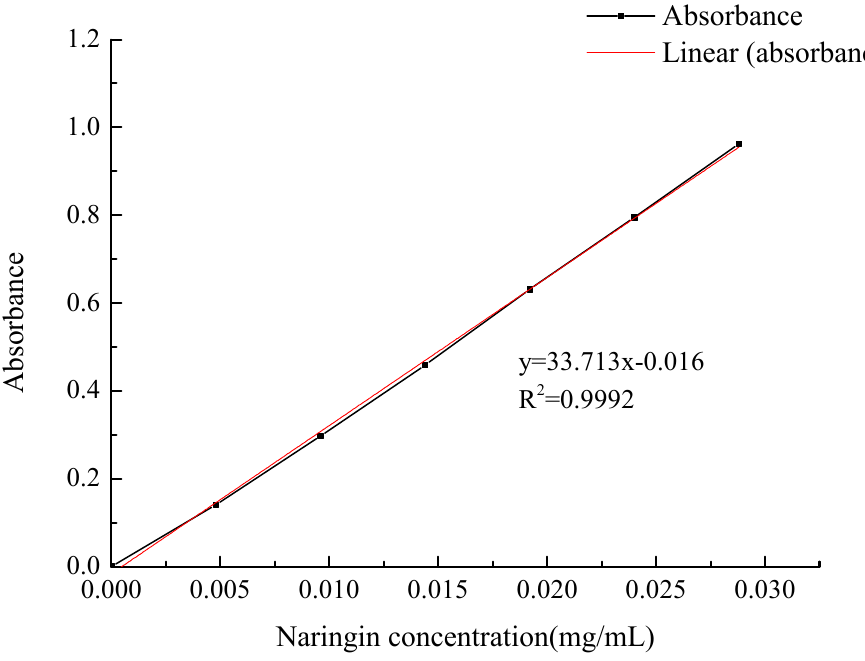
Figure 1. The standard curve of naringin.